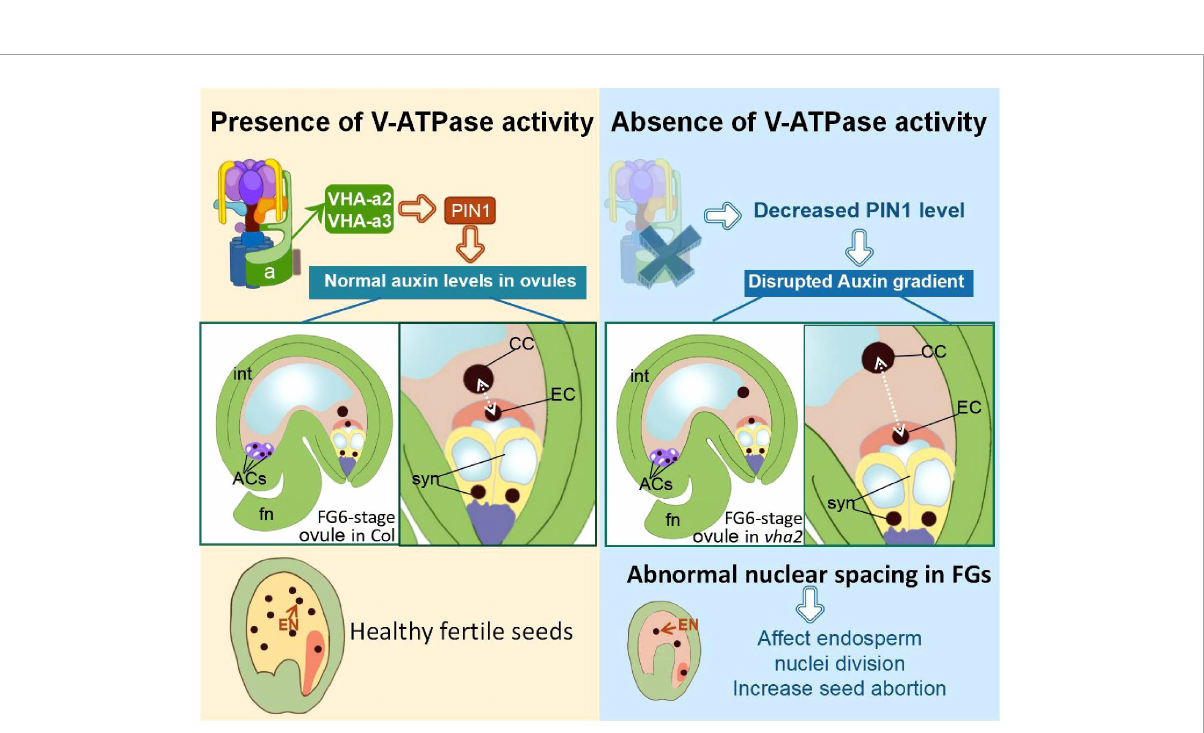
FIGURE8 Schematic diagram of the role of V-ATPase on FGs and later endosperm development. Fn, funiculus; syn, synergid cell; EC, egg cell; CC, central cell; ACs, antipodal cells; int, integuments (inner and